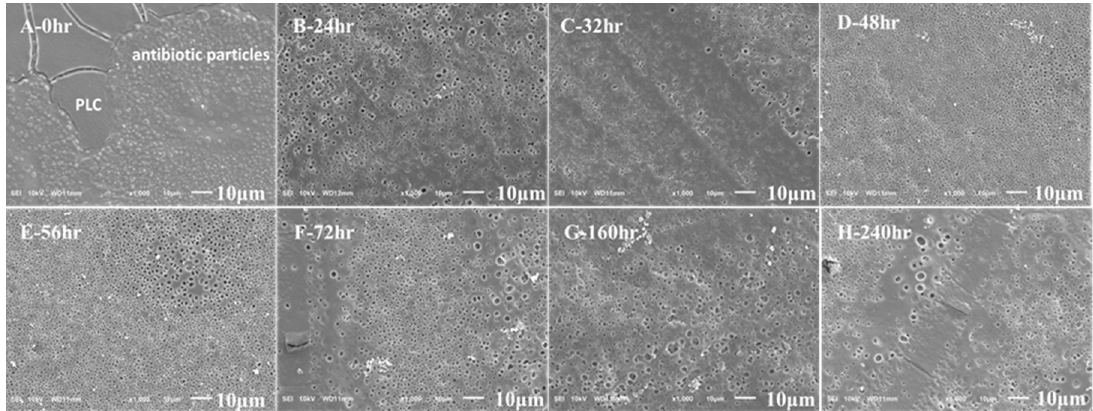
Figure 8. Surface morphology of double coating with antibiotics during degradation time: ( A ) 0 h; ( B ) 24 h; ( C ) 32 h; ( D ) 48 h; ( E ) 56 h; ( F ) 72 h; ( G ) 160 h; ( H ) 240 h.